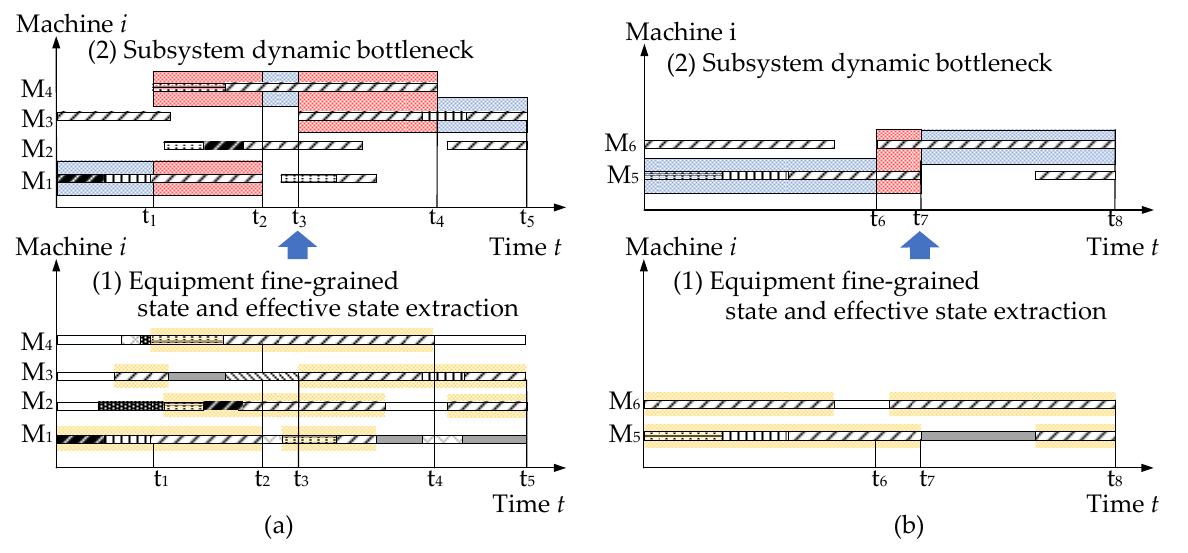
Figure 12. Complex system dynamic bottleneck identification. ( a ) Subsystem 1 dynamic bottleneck identification; ( b ) Subsystem 2 dynamic bottleneck identification.